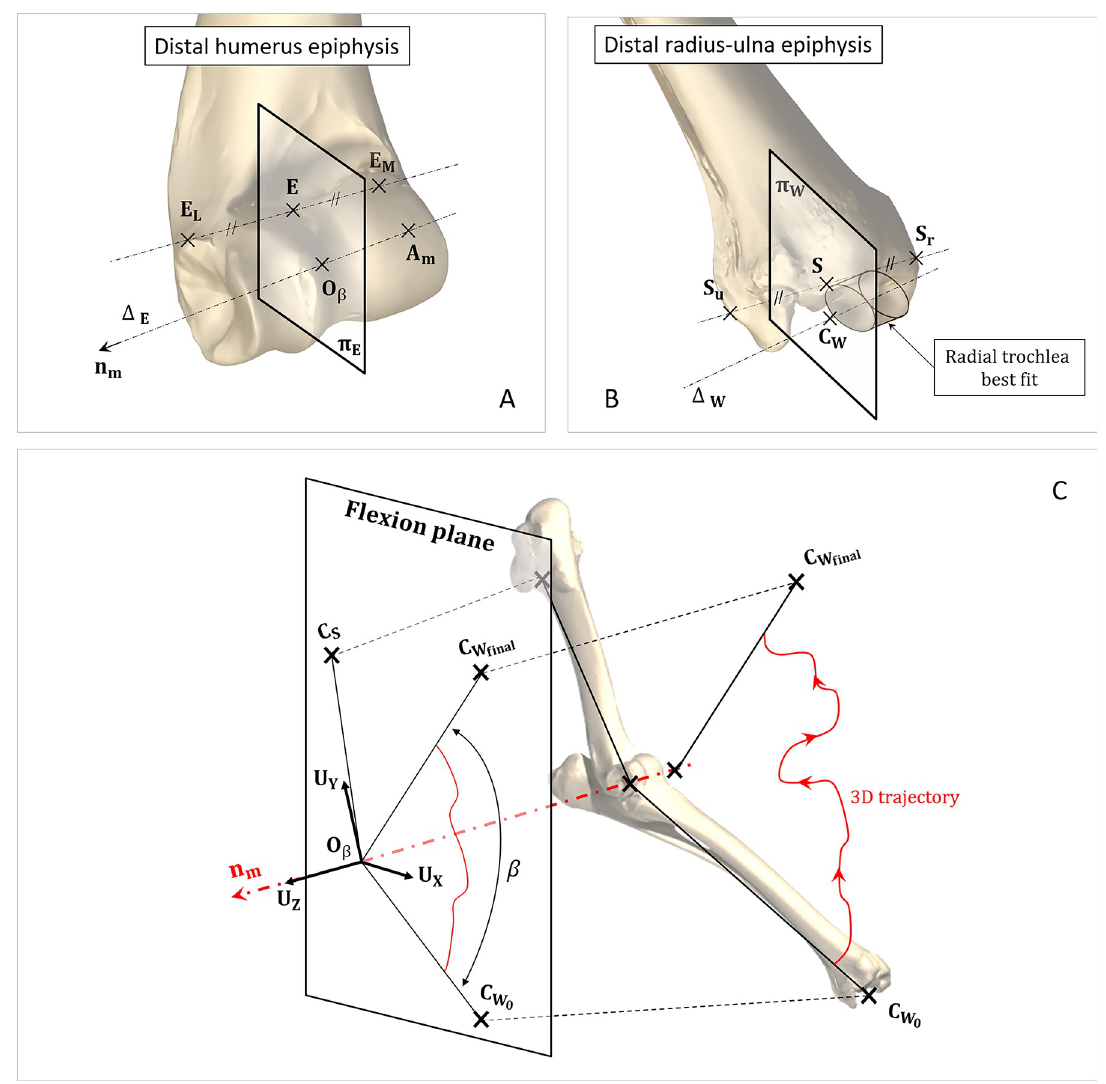
Fig 5. Defined anatomical reference system. (A) Geometric construction of the point O β , origin of the joint frame. (B) Geometric construction of the point C W , centre of the carpal joint. (C) Geometric construction of the elbow joint frame axis. A m : mean of A i points, n m : mean flexion axis, C S : Centre of the a best-fitting sphere of the humeral head.